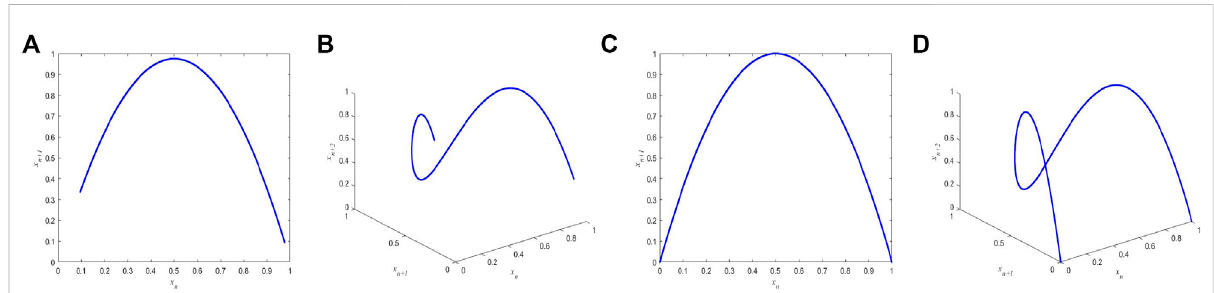
FIGURE 4 TrajectoryanalysisofLogisticMap. (A) 2Dtrajectoryanalysiswith γ =3.9. (B) 3Dtrajectoryanalysiswith γ =3.9. (C) 2Dtrajectoryanalysiswith γ = 10. (D) 3D trajectory analysis with γ = 10.